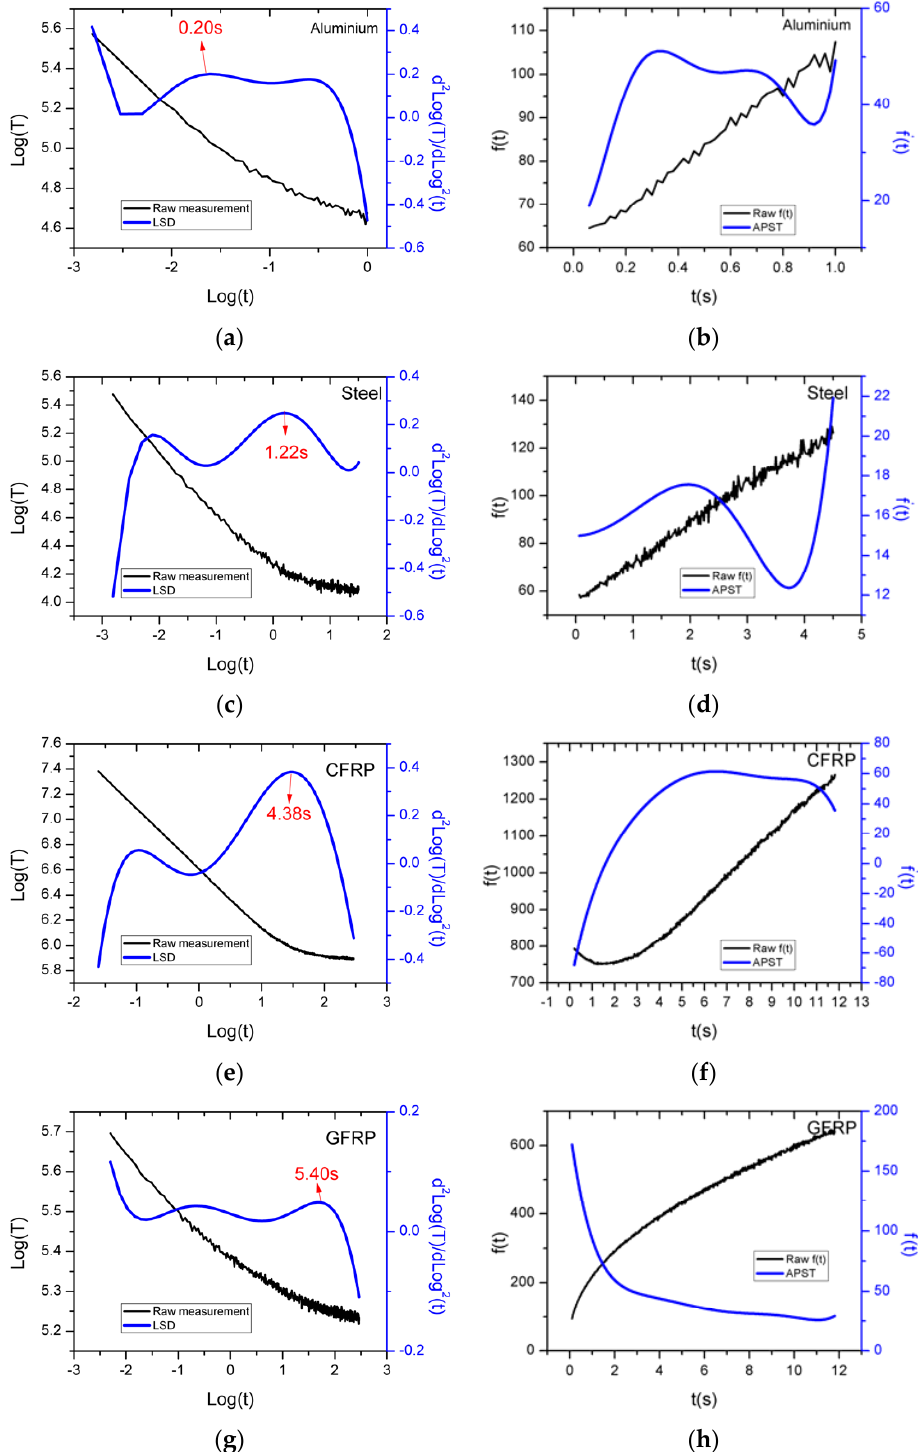
Figure 2. Left: ( a , c , e , g ) RAW thermal plots in the log domain (black curves) and the second derivative plots for aluminium, steel, CFRP, and GFRP plotted using LSD method (blue curves). Right: ( b , d , f , h ) The black curves indicate the raw 𝑓(cid:4666)𝑡(cid:4667) in Equation (8) in the time domain, and the blue curves indicate the first derivative of 𝑓(cid:4666)𝑡(cid:4667) plotted using the APST method for aluminium, steel, CFRP, and GFRP.